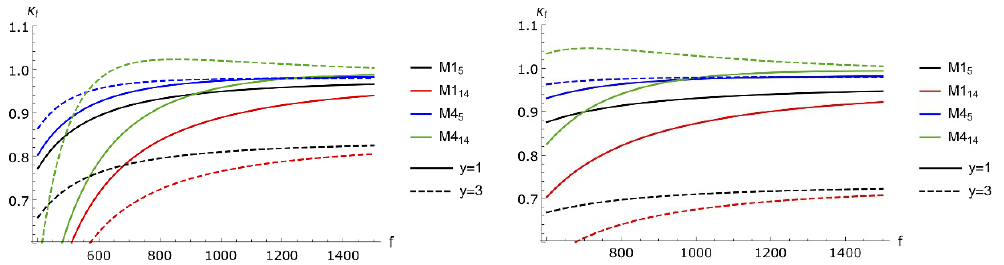
Figure 3 . The top-quark Yukawa coupling in each of the models as a function of f , for M (cid:9) = 1200 GeV, M (cid:9) = 1300 GeV, and y = 1 ; 3, for one top partner (left) and two top part- 1 2 ners